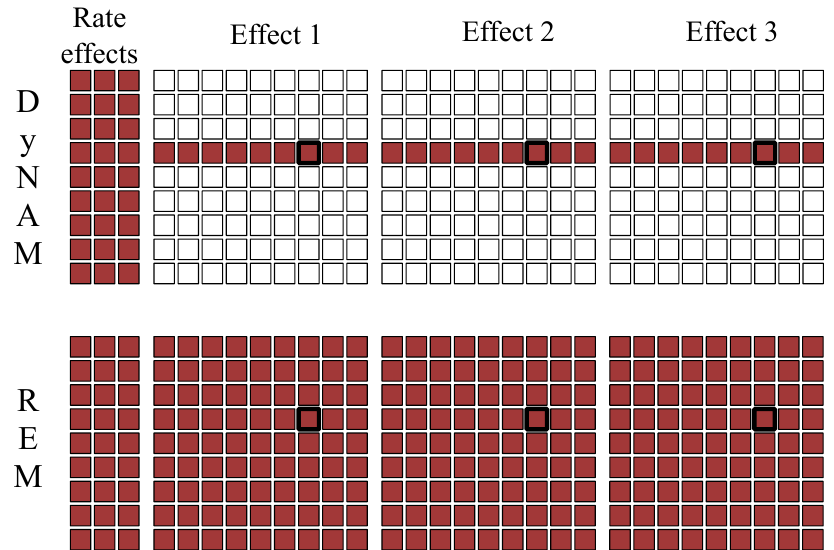
Figure 6: Information used (change of statistics given an event between any pair of actors) for the estimation of DyNAM and REM, respectively. The matrix cells of model statistics of the observed event are marked with a